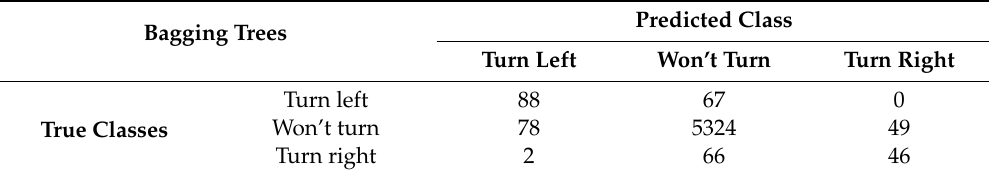
Table 2. The confusion matrix of the bagging trees.